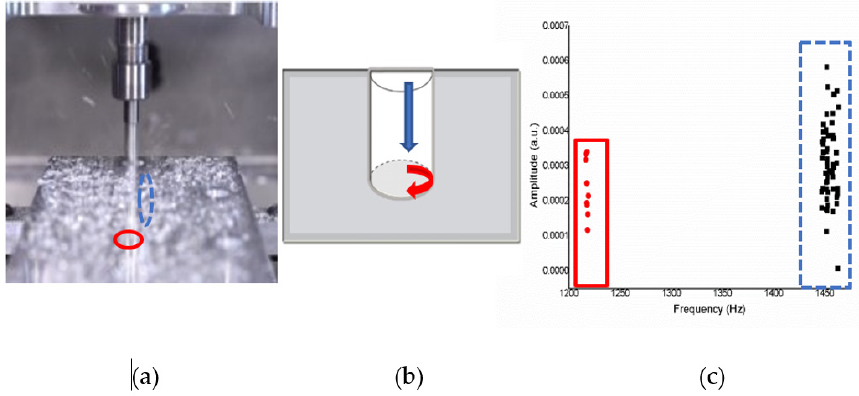
Figure 13. ( a ) Operation sketch, ( b ) trajectory of tool, ( c ) frequency of milling process for XYZ axes.